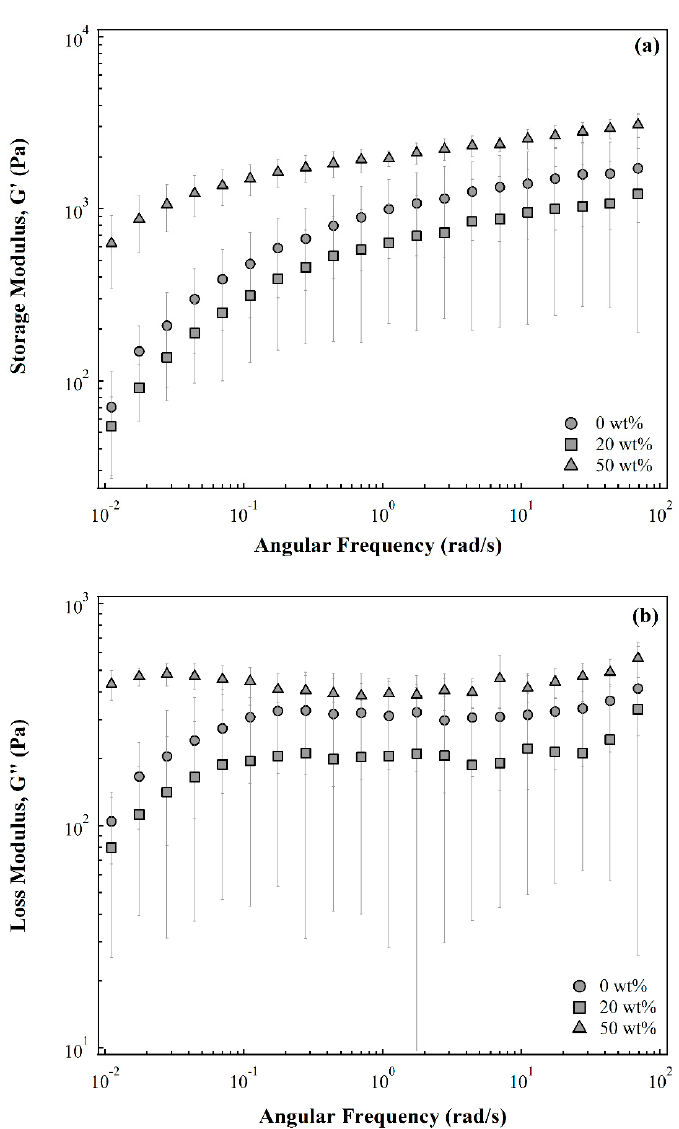
Figure 1. ( a ) Storage modulus, G’ and ( b ) loss modulus, G’’ as a function of angular frequency for